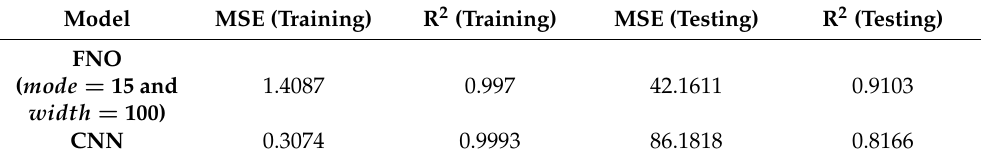
Table 2. A comparison between the performance of the best-performing FNO model and the CNN model in terms of MSE and R 2